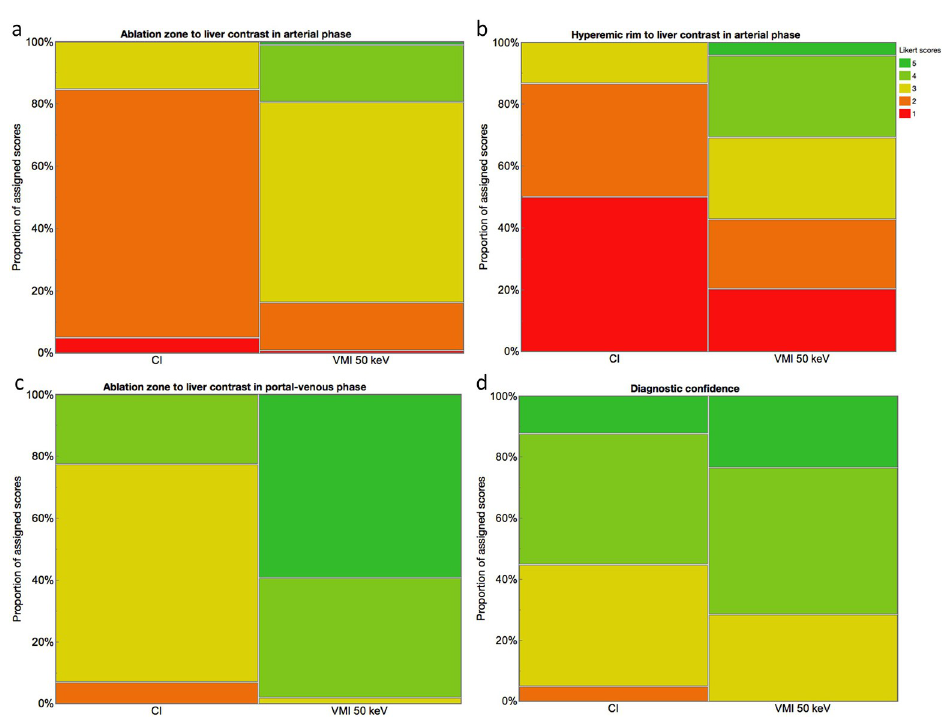
Fig 2. Results of qualitative analysis. Ablation zone as well as hyperemic rim to liver contrast in arterial phase, ablation zone to liver contrast in portal-venous phase and diagnostic confidence received significantly higher ratings in virtual monoenergetic images (VMI) with 50 keV as compared to conventional images (CI)